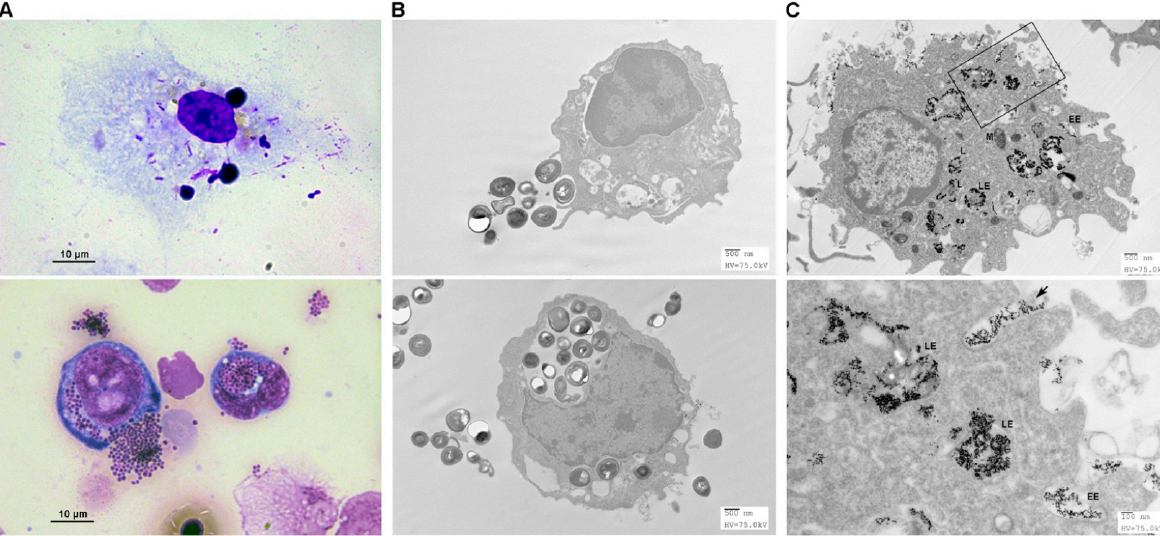
Figure 4. Endocytosis of pathogens or gold nanoparticles by FMs. FMs were grown on coverslips and fed with pathogens ( S. Typhimurium or Staphylococcus aureus) or 5 nm gold particles for 12 h. Then they were subjected to Diff-Quik staining or sample preparation for transmission electron microscopy. ( A ) Diff-Quik staining revealed the capacity of FMs for pathogen phagocytosis. Salmonella were taken up in solitude by FMs (upper panel), whereas Staphylococci were engulfed in grape-like clusters (lower panel). ( B ) In electron microscopic examinations, FMs stretched their pseudopodia to engulf the large particles of 0.5–1 µ m bacteria. This phagocytosis led to a huge phagosome by the fusion of the cell membrane. ( C ) FMs took up gold nanoparticles by invagination (arrow, lower panel) of the cell membrane to form a vesicle as the endosome. The early endosomes (EE) had a uniform, electronlucent appearance without much internal material. The late endosomes (LE) contained closed-packed luminal vesicles with internal membrane fragments. The lysosomes (L) appeared to be more homogeneous in structure near the nuclei. The mitochondria (M) are easily recognized by their internal